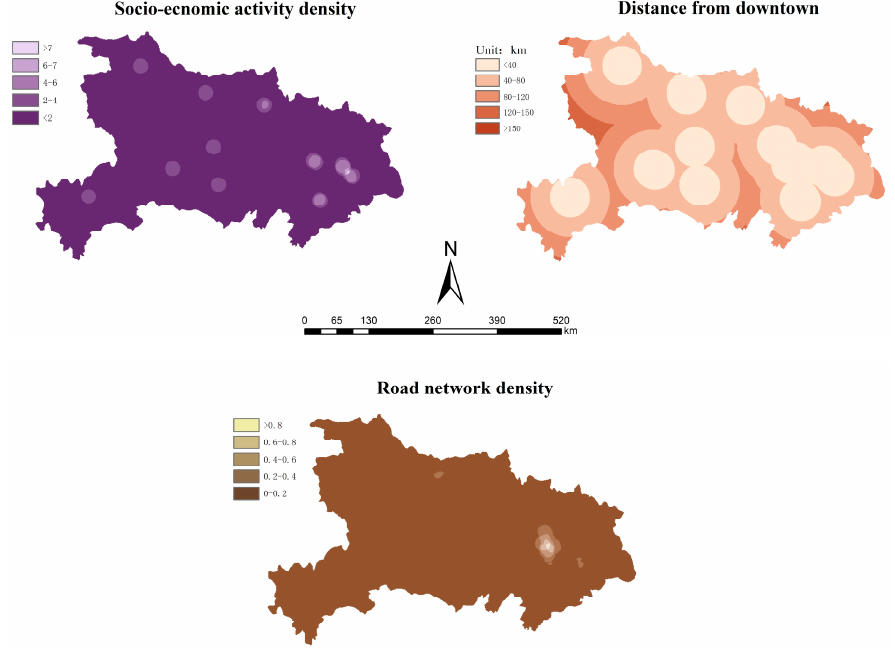
Figure 5. Non-agriculturalization sensitivity.